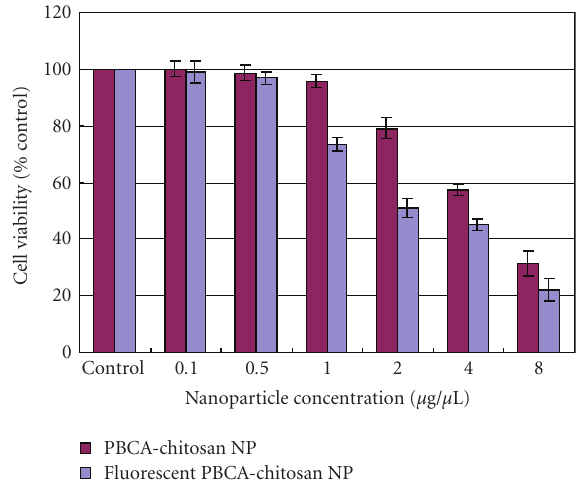
Figure 6: Cytotoxicity of cationic chitosan coated PBCA-NPs analyzed by MTT assay, 24 hours posttreatment ( n = 8). Columns, mean; bars, SD, P < . 001 as evaluated by one-way ANOVA using SPSS 17.0